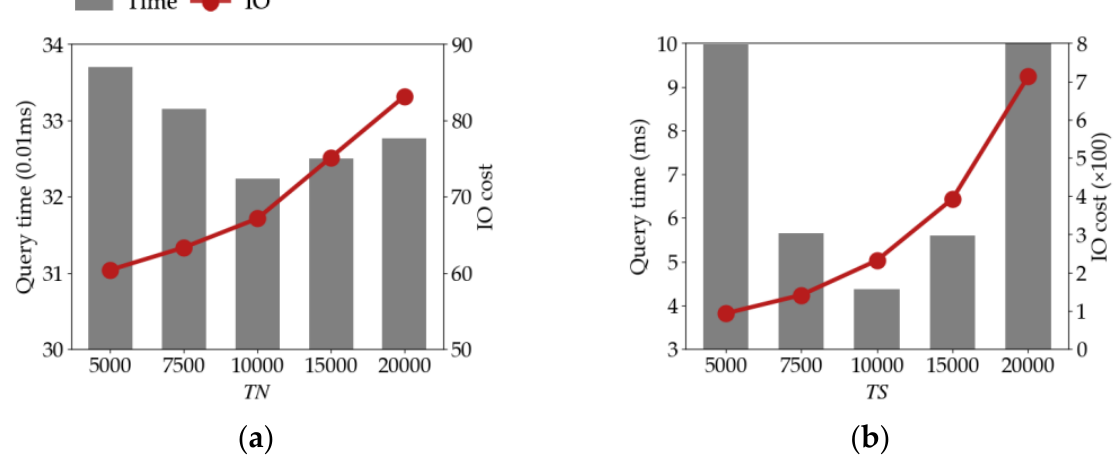
Figure 4. Effect of thresholds on range query. ( a ) TN . ( b ) TS .